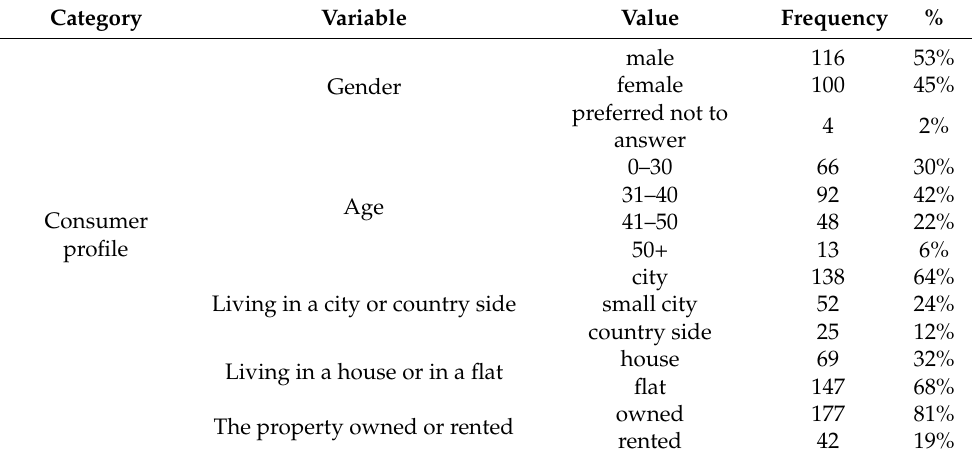
Table 1. Consumer